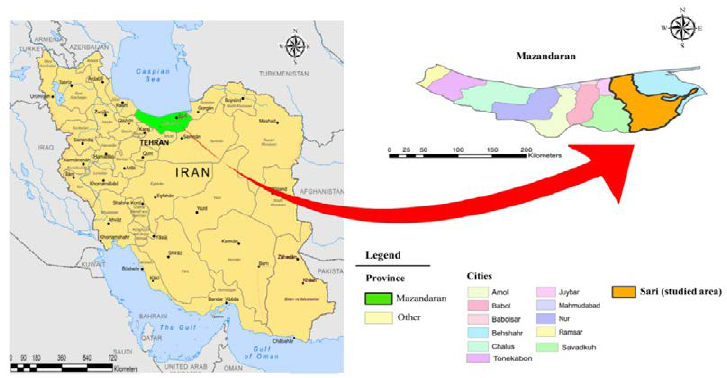
Fig. 1: Geographic location of the study area in Sari, Mazandaran Province, Iran